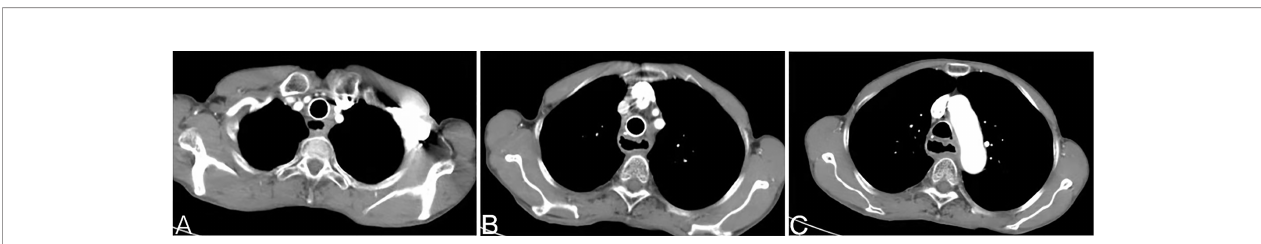
FIGURE 3 | A chest CT at 1 month after arterial infusion chemotherapy shows that the soft-tissue shadow of the esophagogastric anastomosis to be reduced signi fi cantly (A – C)